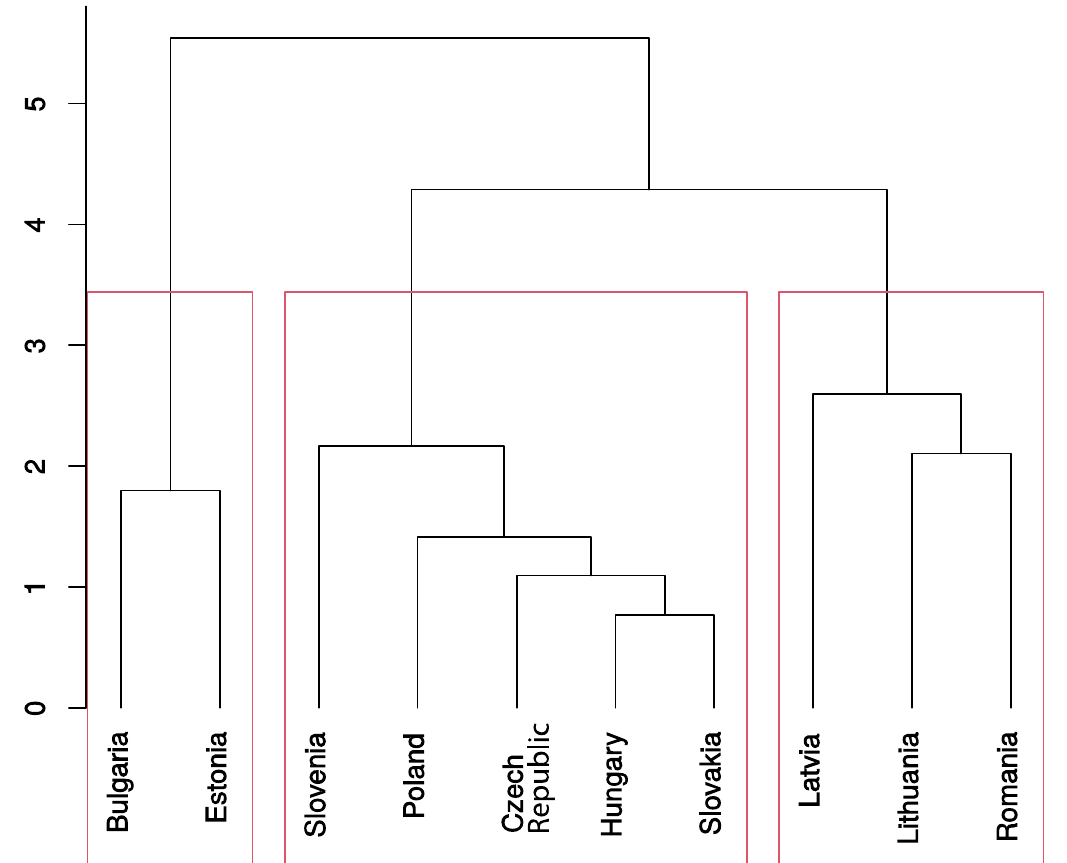
Figure 4. Classification of CEE countries in 2018 in terms of the level of energy transformation according to Ward’s method.